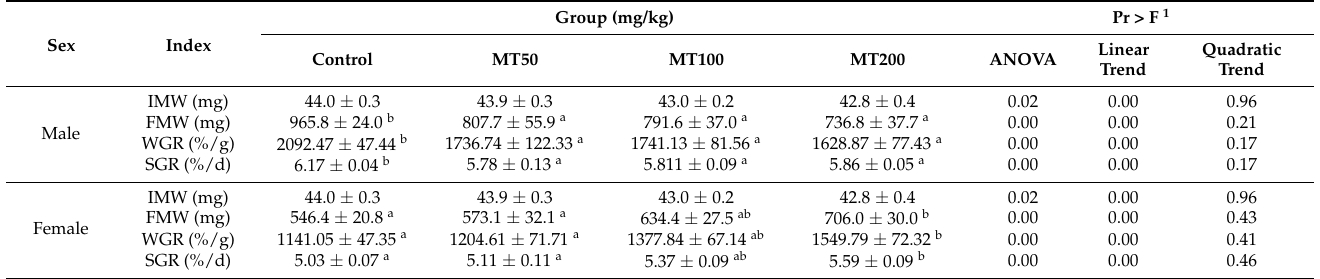
Table 4. Effects of different concentrations of 17 α -methyltestosterone on growth performance of juvenile